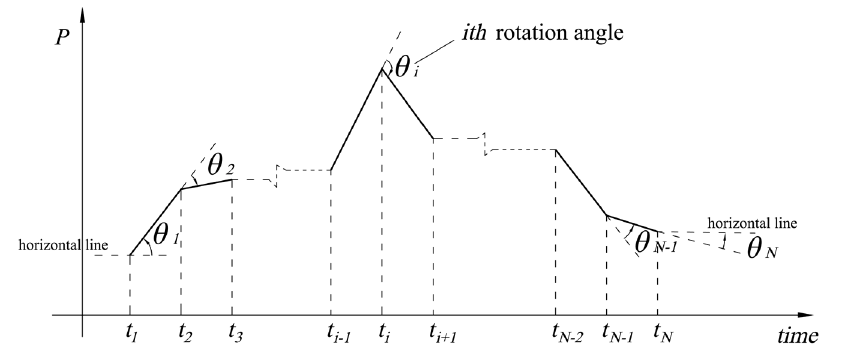
Figure 4. Schematic diagram of the rotation angles and line segments of the output process.